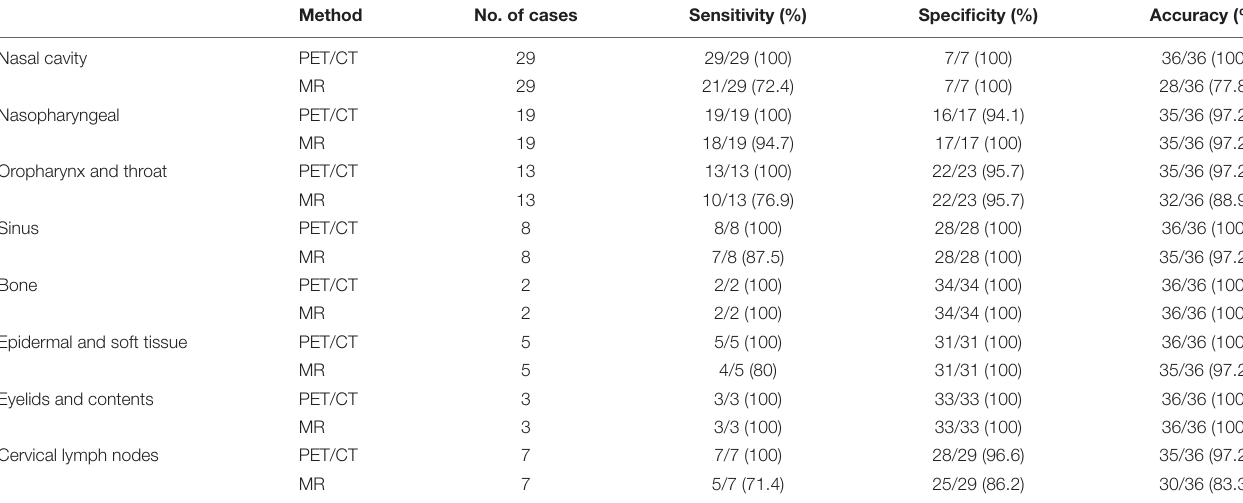
TABLE 3 | The efficacy of 18 F-FDG PET/CT and 18 F-FDG PET/MR in early-stage ENKTL in different nasopharyngeal anatomical regions. Method No. of cases Sensitivity (%) Specificity (%) Accuracy